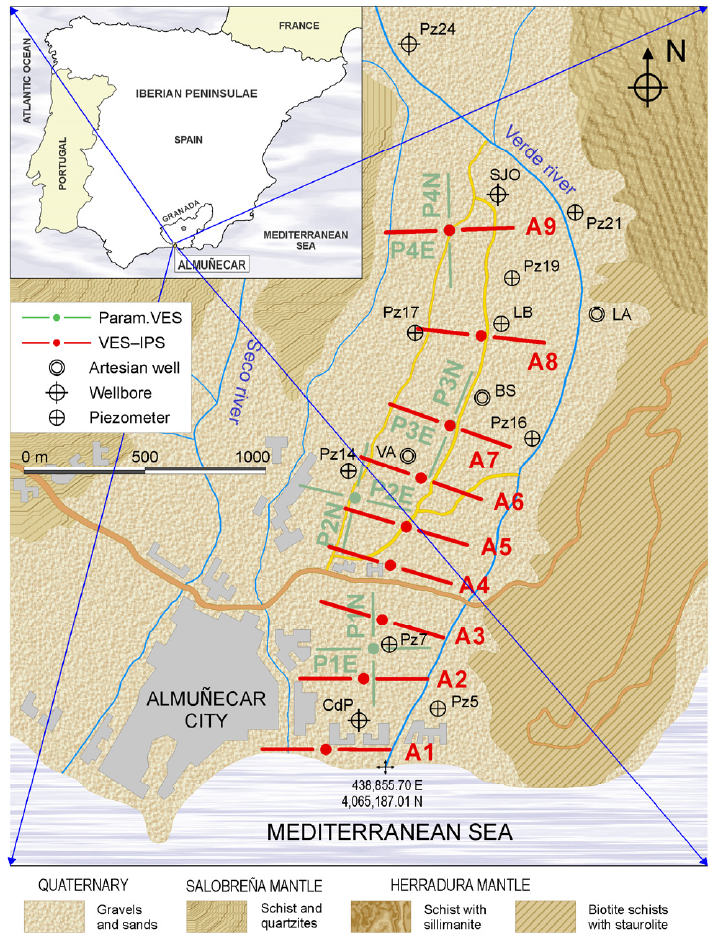
Figure 5. Location of the study area, a sketch of the locations of the soundings, and geology of the area. The coordinates of the river’s mouths are Seco River 437,720.62 m E & 4,065,188.01 m N, Verde River 438,855.70 m E & 4,065,187.01 m N. Four vertical electrical parametric soundings and 18 vertical electrical and IP sound- ings (VES-IPS) were performed; their locations are shown in Figure 5. In all cases, a Schlumberger array was used, with interelectrode distances from 1.5 m to a final